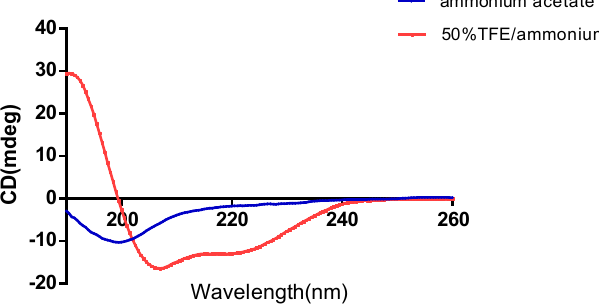
Figure 6. Circular dichroism (CD) spectra of Dermaseptin-PH (50 µ M) in 10 mM ammonium acetate/water solution (blue line) and in 50% 2,2,2-trifluoroethanol (TFE)/10 mM ammonium acetate/water solution (red line).